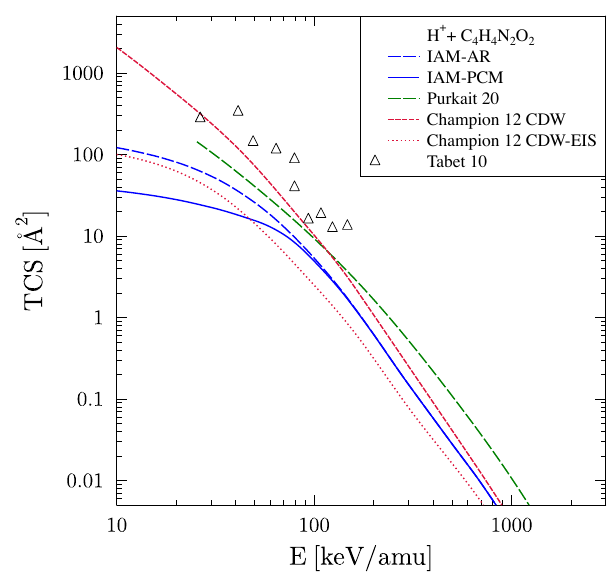
Figure 9. Net electron capture cross section for collisions of protons with uracil (C 4 H 4 N 2 O 2 ). The blue dashed curves show the IAM-AR results, while the blue solid curves are obtained with the IAM-PCM. The experimental data are from Reference [38], the other theoretical data are from References [39–41]. A lower bound for the experimental uncertainties (not shown) can be estimated from the electron capture branching ratio (shown in Figure 1 of Reference [38]) to be on the order of 20% at the